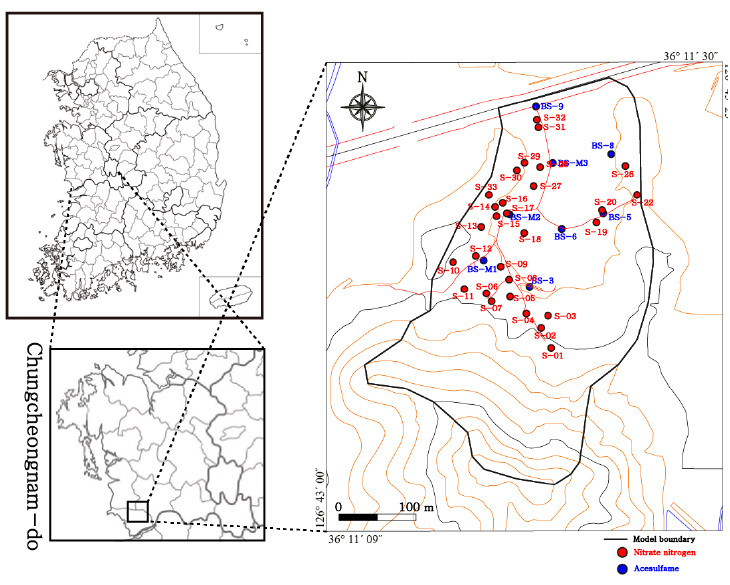
Figure 1. The location of the study area and the wells that were investigated for acesulfame and